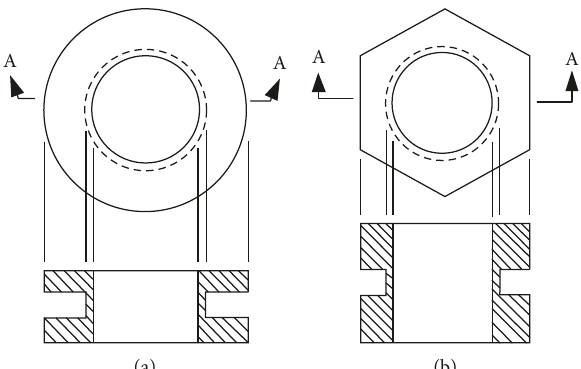
Figure 15: Two typical specimen types used in TSHB experiments. (a) Tubular specimen with cylindrical flanges. (b) Tubular specimen with hexagonal flanges